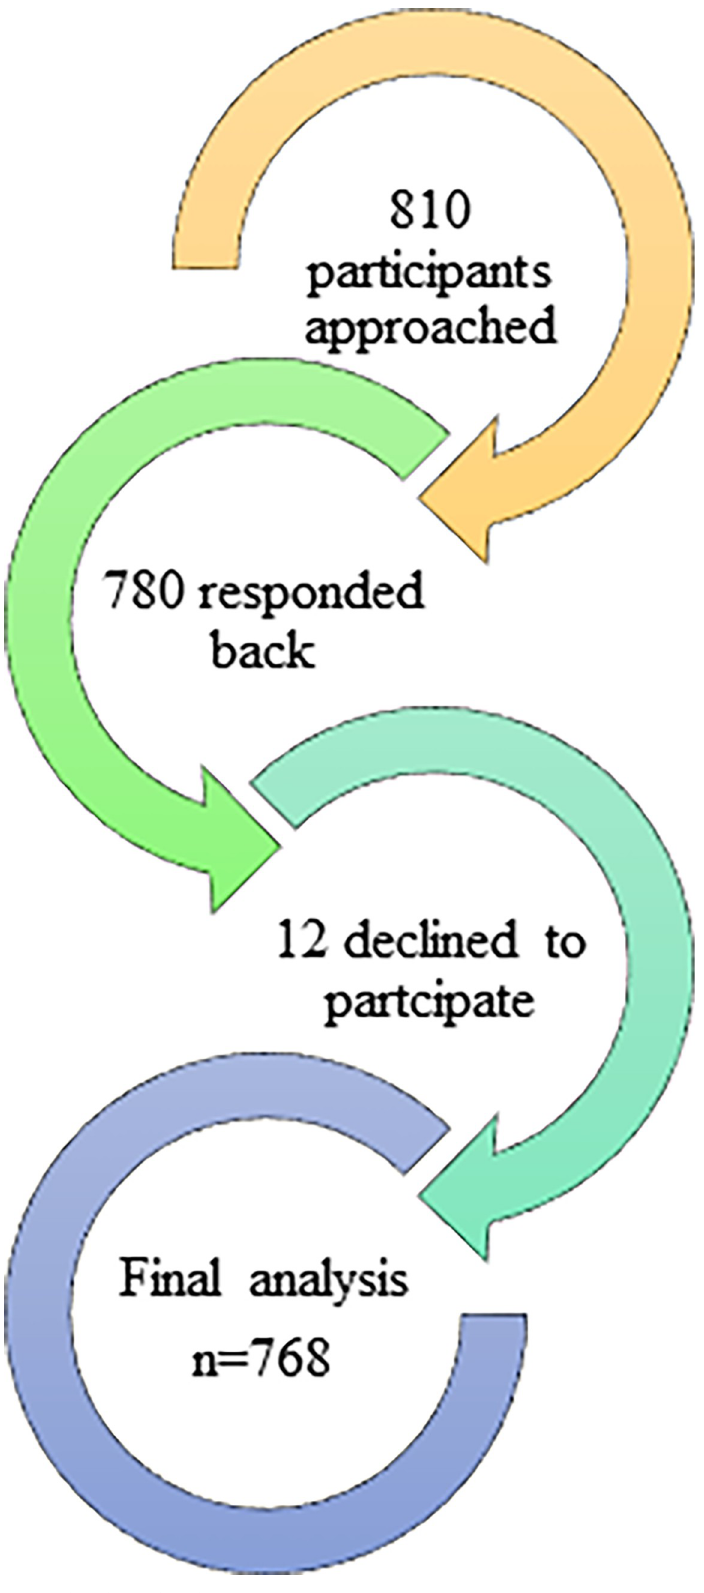
Fig 2. Flowchart of study